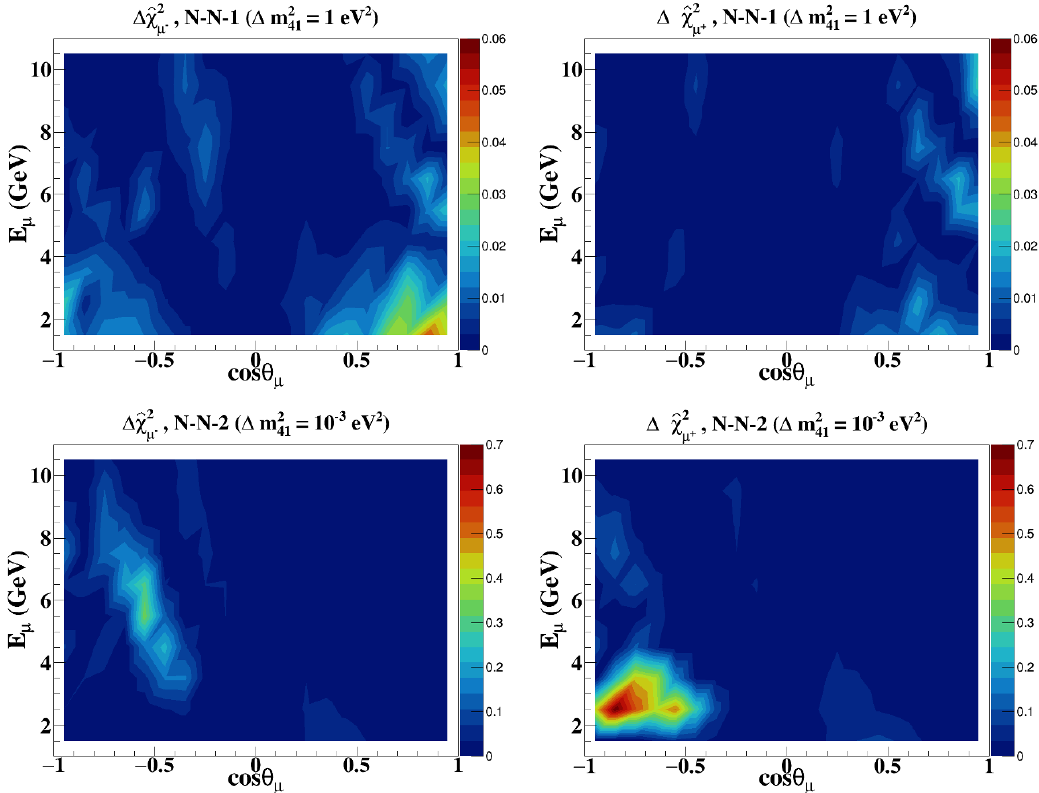
Figure 5 . The distributions for (cid:1) (cid:31) 2 , i.e. (cid:1) (cid:31) 2 per energy-cos (cid:18) interval, for (cid:22) (cid:0) (left panel) and b (cid:22) + (right panel) events generated using j U e 4 j 2 = 0 : 025, j U (cid:22) 4 j 2 = 0 : 05, and j U (cid:28) 4 j 2 = 0. The top panels correspond to (cid:1) m 2 = 1 eV 2 (N-N-1 con(cid:12)guration), while the bottom panels correspond to 41 (cid:1) m 2 = 10 (cid:0) 3 eV 2 (N-N-2 con(cid:12)guration). Only the information on muon energy and direction is 41 used. Note that the scales in the top and bottom panels are